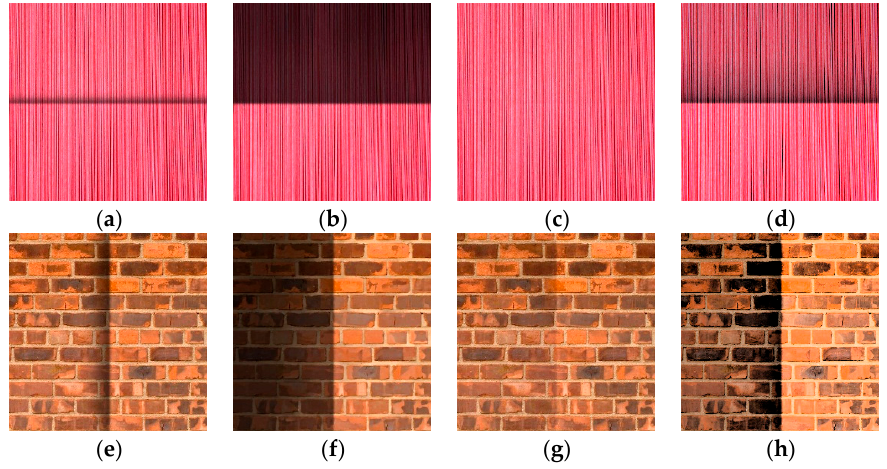
Figure 8. Image reconstruction by different methods. ( a , e ) Ng; ( b , f ) HoTVL1; ( c , g ) proposed; ( d , h ) mutiscale Retinex.